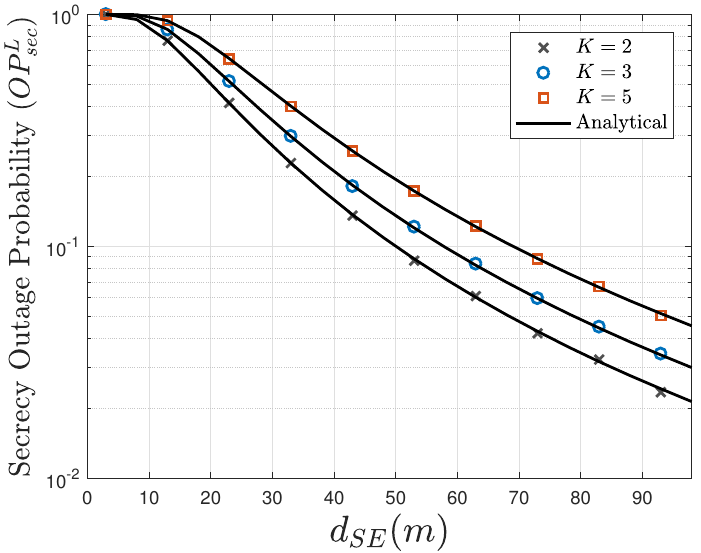
Figure 6. The lower bound of the secrecy outage probability ( OP L sec ) versus the distance between Alice and E for different number of antennas K . For the main channel, κ = 0, µ = 1, and for the wiretap channel, κ e = 0, µ e = 1. ¯ γ E = 1 dB, ¯ γ B = 10 dB, C th = 1, N = 2, n e = 1, β = 3, d Ap = 5 and d p 1 B